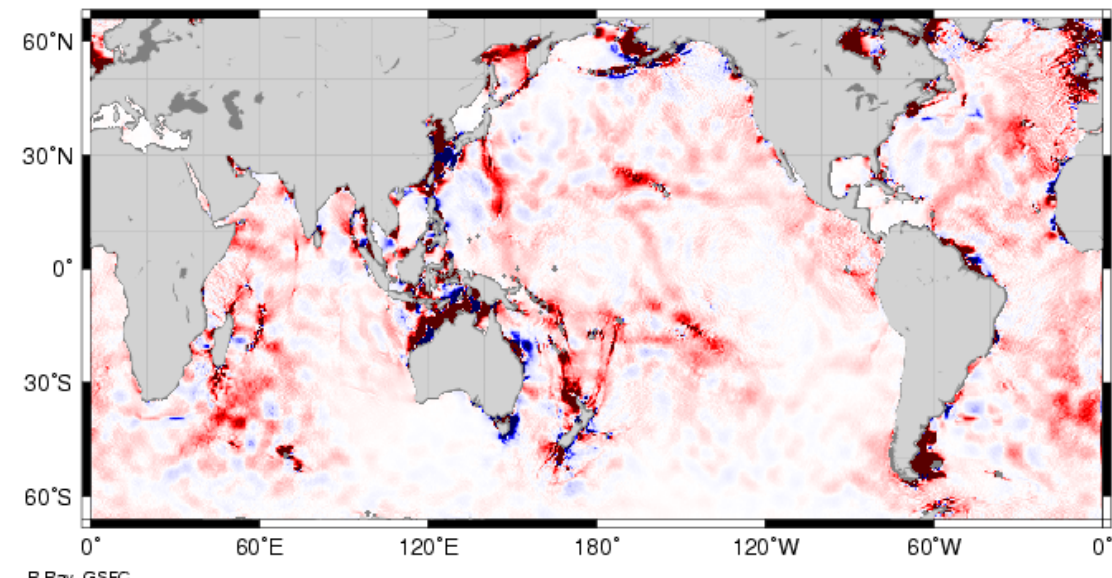
Figure 8. Tidal energy dissipation, the red areas are the most energetic [13]. c (cid:13) Reproduced with permission from NASA - Goddard Space Flight Center, NASA - Jet Propulsion Laboratory and Scientific Visualization Studio,